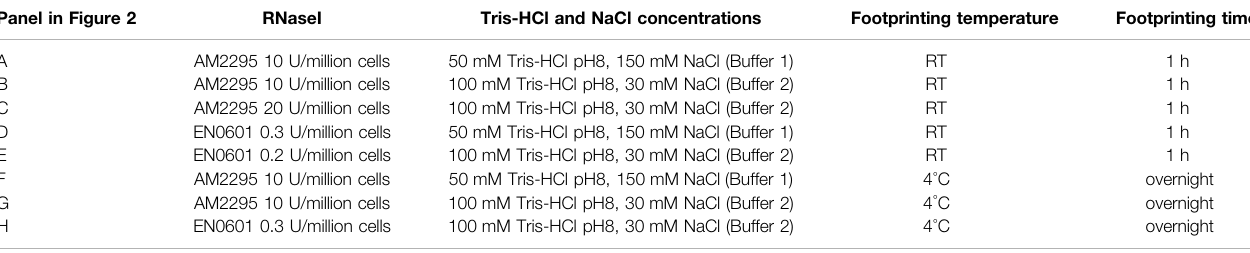
RibosomefootprintingconditionstestedinhumanSH-SY5Ycellswithreferencetodatain Figure1 ,RNaseItypeandunits,Tris-HClpH8andNaClconcentrations,incubationtemperature and incubation time.